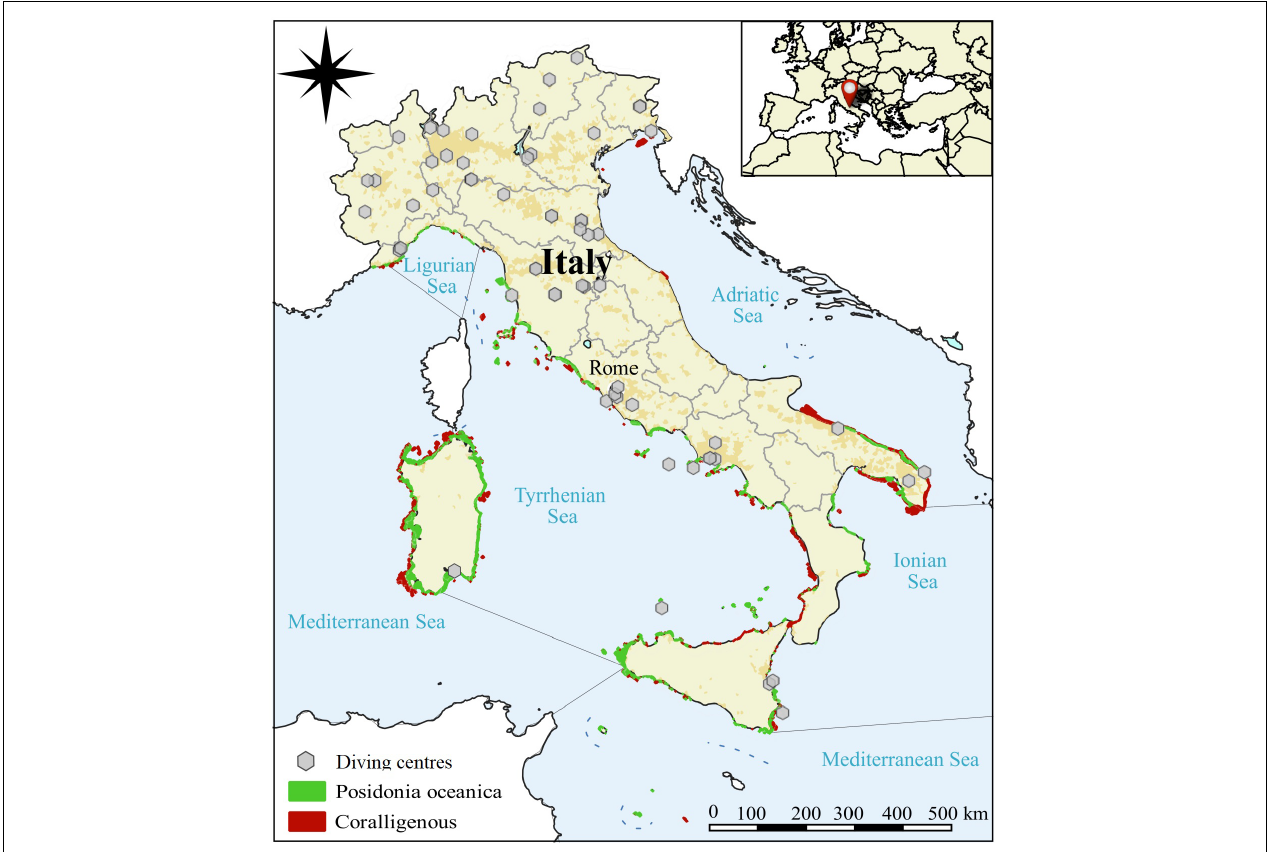
FIGURE 1 | Location of the study site and distribution of P. oceanica meadows and coralligenous assemblages along the Italian peninsula Information contained here has been derived from data that is made available under the European Marine Observation Data Network (EMODnet) Seabed Habitats project (http://www.emodnet-seabedhabitats.eu/), funded by the European Commission’s Directorate-General for Maritime Affairs and Fisheries (DG MARE). Gray dots represent the diving centers that have received the